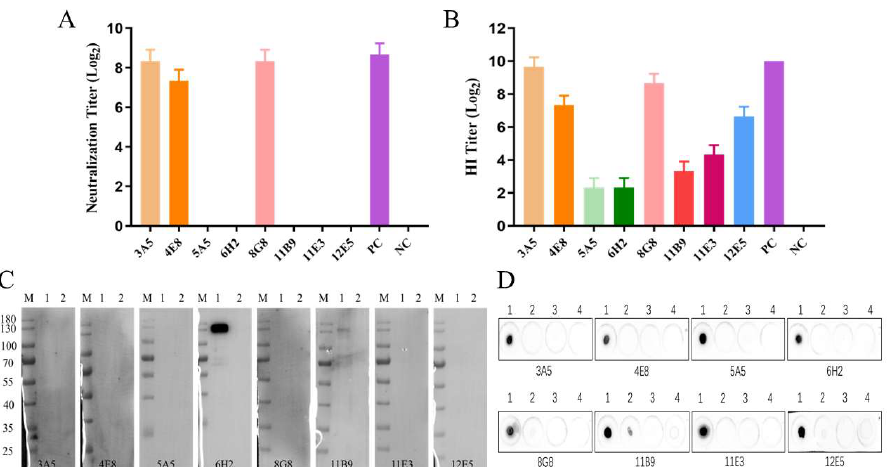
Figure 3. Identification of mAbs. ( A ) Neutralizing activity of mAbs. PC, H9N2 AIV-positive chicken serum. NC, H9N2 AIV-negative mice serum. ( B ) Hemagglutination inhibitory activity of mAbs. PC, H9N2 AIV-positive chicken serum. NC, H9N2 AIV-negative mice serum. ( C ) Evaluation of the response between the mAbs and HA protein by Western blotting. M, protein marker. Lane 1, HA protein. Lane 2, TP309 soluble protein used as negative control. ( D ) Specificity detection of the mAbs react with different virus by dot blotting. Lane 1, H9N2 AIV virus. Lane 2, H5N1 AIV virus. Lane 3, NDV virus. Line 4, TP309 soluble protein. All the data were presented as means with error bars. 3.4. Mapping of B Cell Epitope on the HA Protein To map the linear epitopes recognized by the two mAbs, 41 overlapping peptides containing an offset of seven amino acids were synthesized (Figure 4A and Table 1). The peptides binding to the mAbs were determined via dot blotting and indirect ELISA. As shown in Figure 4B,C, 475 CFELYHKCDDQCMETIRNGT 494 (P39) was recognized by mAb 6H2. To further confirm the precise epitope of the H9N2 HA protein, five truncated peptides of P39 were synthesized; the results of dot blotting and indirect ELISA showed that 480 HKCDDQCM 487 (P39-5) was recognized by mAb 6H2 (Figure 4D,E).